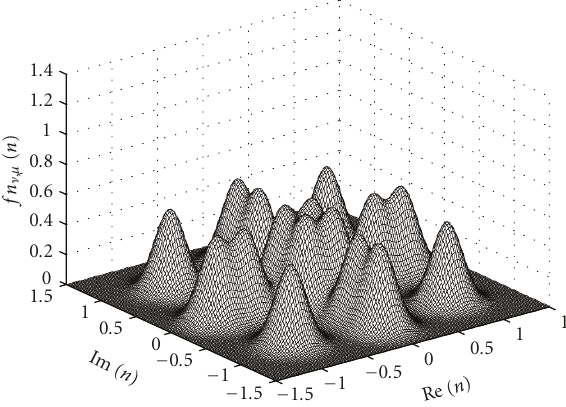
Figure 3: Pdf of ISI, MAI, and noise with Gaussian assumption for ( E b / N 0 ) = 10dB. 10log 10